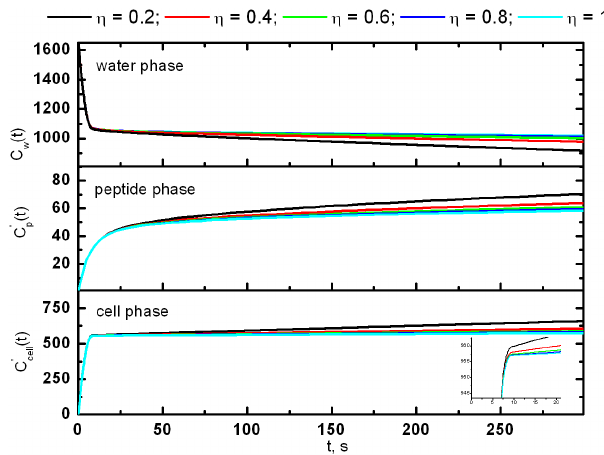
Fig. 2. The kinetic curves of the injected compound con- centrations in water, cells and peptide phases for di®erent viscosity means (cid:3) (from 0.2 cPz to 1